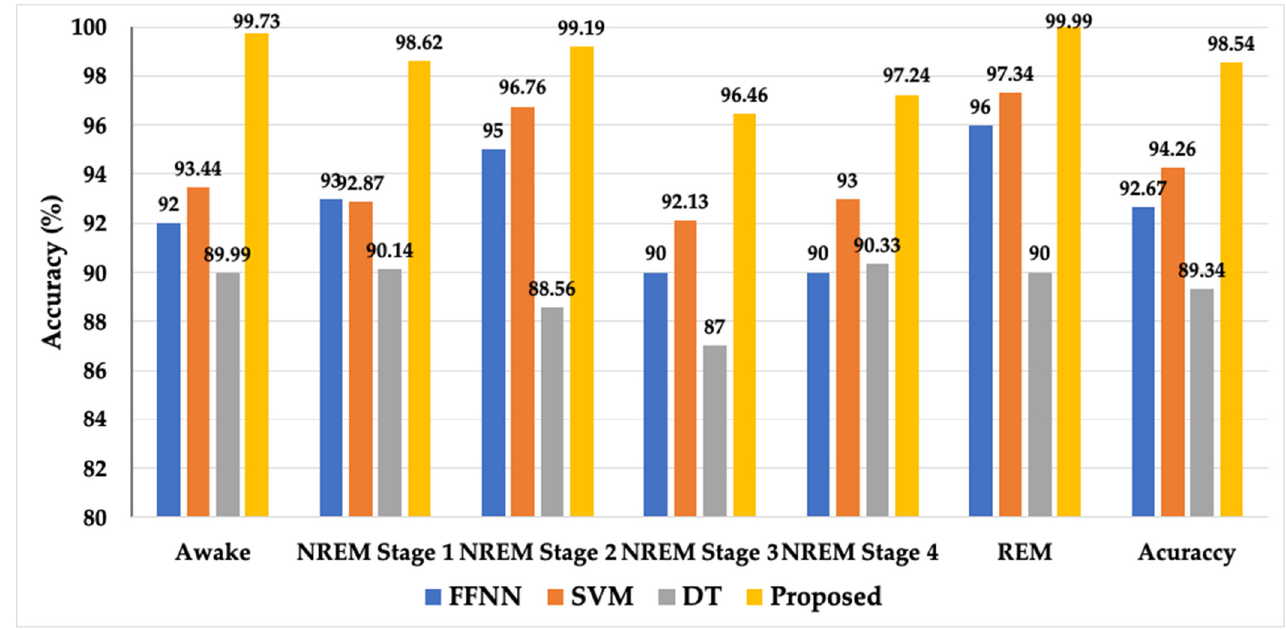
Figure 6. Classification performance of the proposed algorithm and other popular classifiers. Table 3. The comparison results of the proposed model with other state-of-the-art studies.